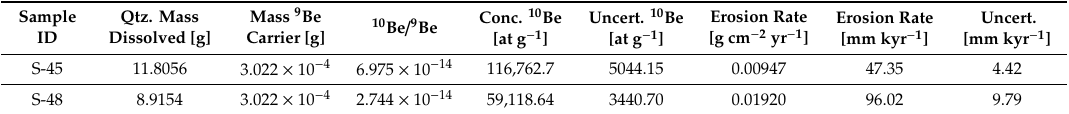
Table 5. Bedload sediment sample data and AMS results used for producing 10 Be catchment wide erosion rates with CRONUS-Earth online calculator 2.3. Scaling scheme applied: Lal [43] / Stone [51]. Samples were spiked with SCHARLAU Be standard solution 1000 mg /